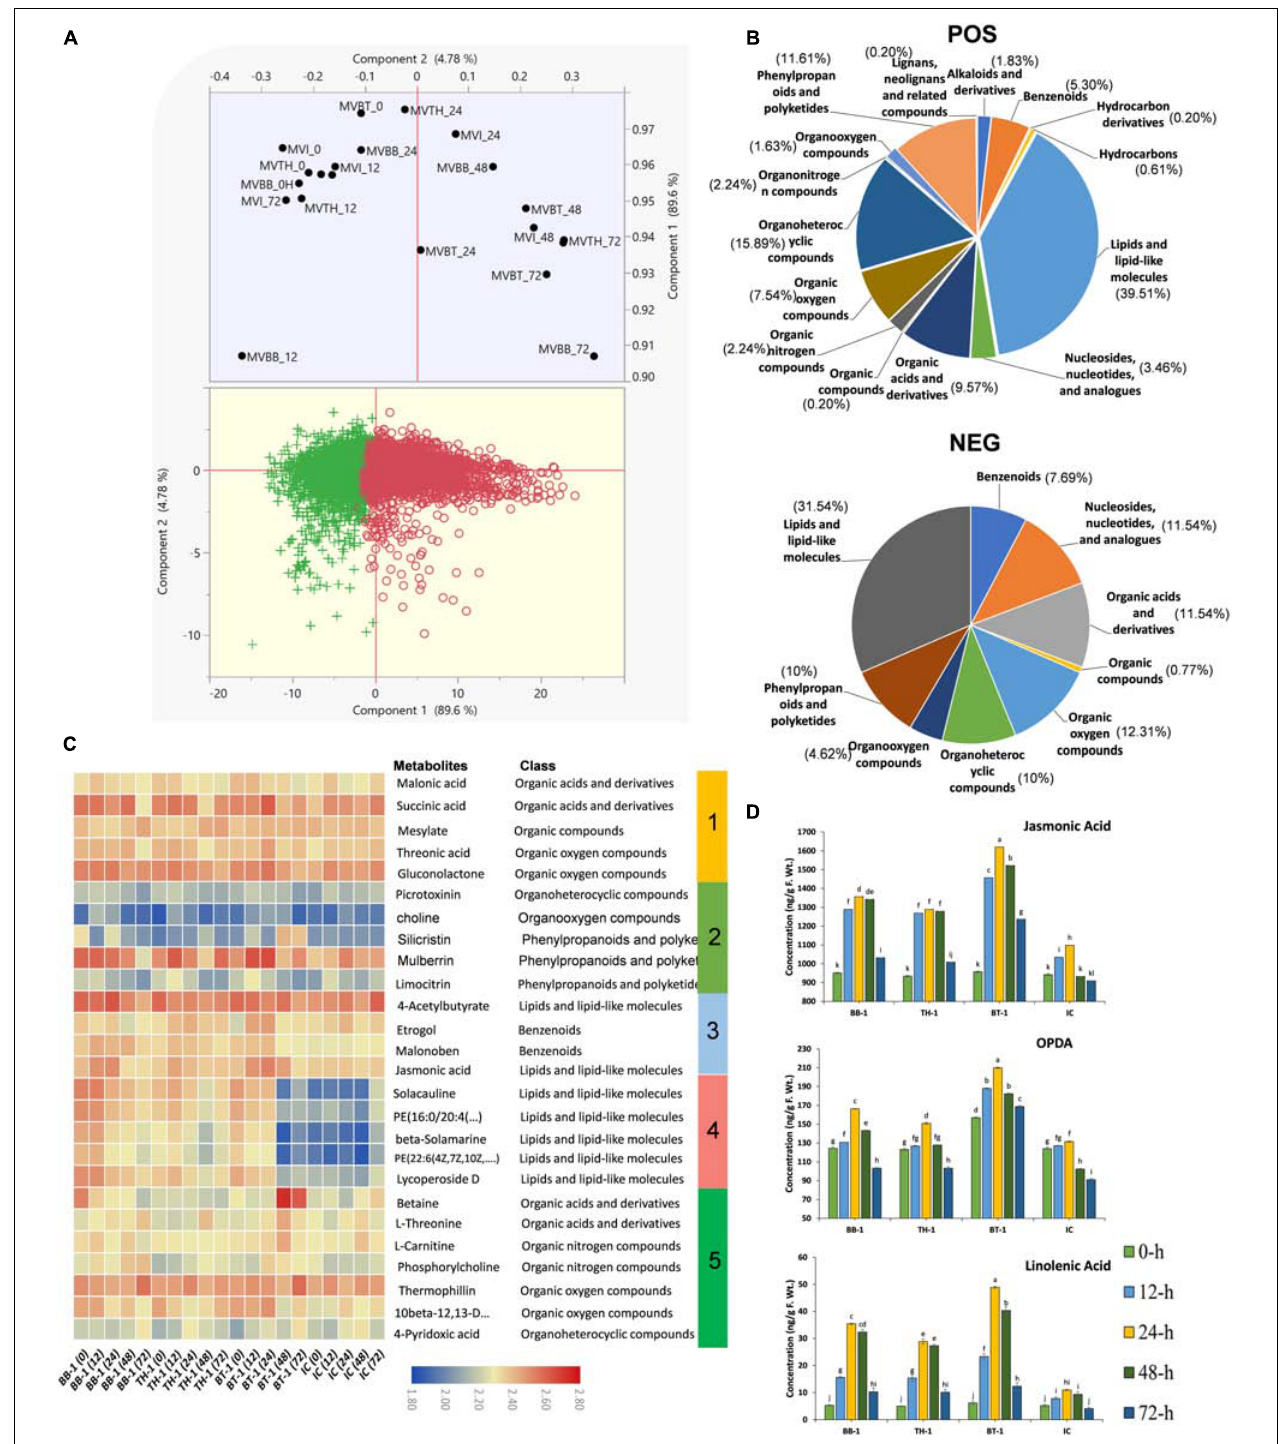
FIGURE 7 | Metabolome profiling of maize inoculated with single and consortium of B. bassiana OFDH1-5 and T. asperellum GDFS1009 and subjected to O. furnacalis attack. (A) PCA plot show divergence in metabolome data among treatments (MVBB, MVTH, MVBT, and MVI stands for BB-1, TH-1, BT-1, and IC, respectively). (B) Pie chart showing the percentage distribution of differentially annotated metabolites in different classes. (C) Hierarchical clustering of identified abundant metabolites. (D) Concentration of phytohormones in maize plants. Data is mean of three replicates and different lower-case letters above each bar indicate significant differences among treatments ( p < 0.05). Treatments include (BB-1) seed treatment with B. bassiana OFDH1-5, (TH-1) seed treatment with T. asperellum GDFS1009, (BT-1) seed treatment with a consortium of B. bassiana OFDH1-5 and T. asperellum GDFS1009, (IC) no inoculation.